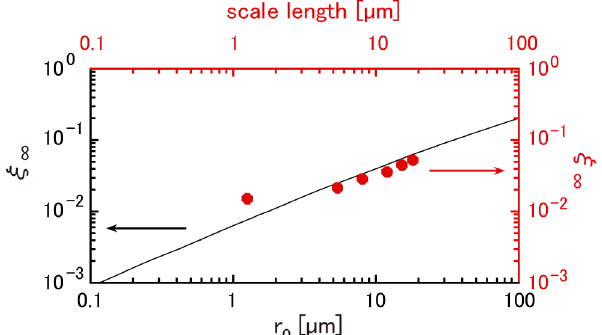
6. Fraction of escaping electrons as a function of initial plasma radius obtained from the model calculation (solid line) and as a function of scale length (circles). The deviations of the fractions calculated from Fig. 2 are about